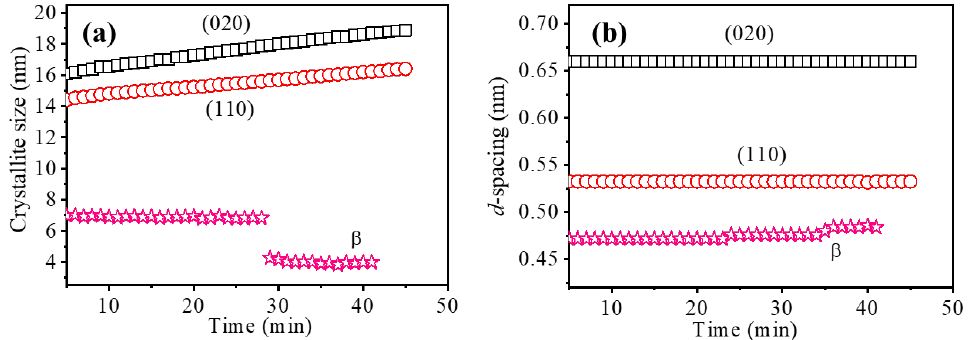
Figure 7. Changes in ( a ) crystallite size and ( b ) d- spacing of the (020), (110) and β reflections of two-step-drawn PHBV films during annealing at 130 °C.